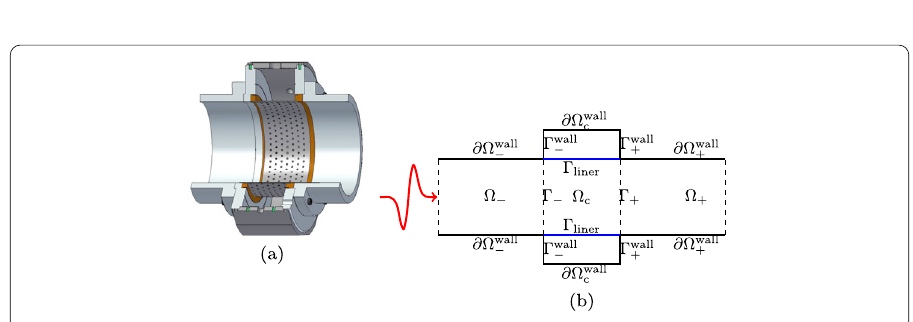
of the cross section are scaled like δ 2 as well as the thickness of the perforated wall, see Fig. 1. As δ → 0, the holes merge and the domain Ω δ